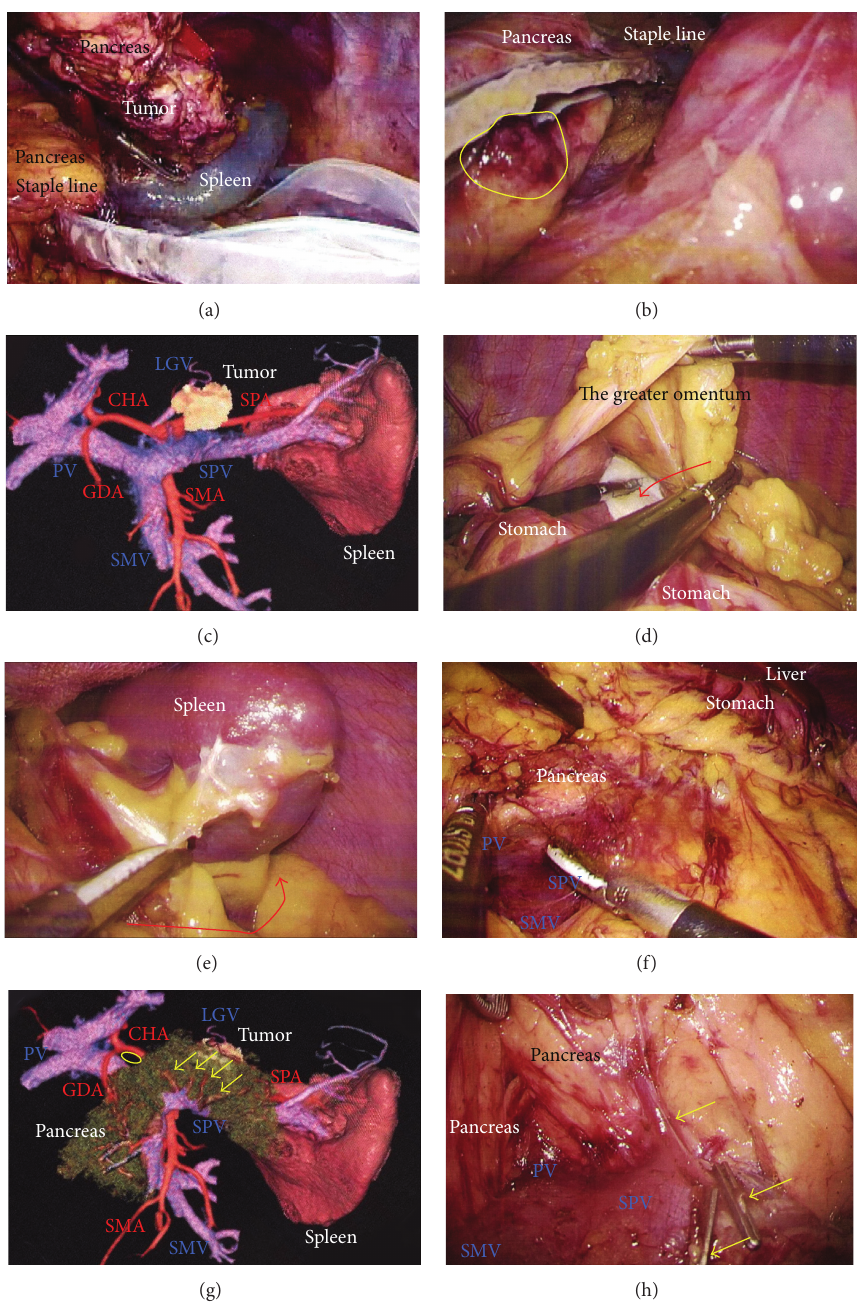
Figure 4: (a) The specimen was extracted through a 3 cm incision in an endobag to prevent dissemination by direct contact with the tumor. (b) The pancreatic stump and capsule were checked carefully. Subtle injury to the pancreatic membrane caused postoperative leakage of pancreatic fluid (yellow circle). (c) The tumor location and invasive signs were assessed carefully. (d) Gauze was placed on the splenic hilus as a landmark. The greater omentum was then cut (red arrow), and the omental bursa was opened. The left gastroepiploic vessels were cut. (e) The splenocolic ligament along the inferior spleen was then cut (red arrow). It was critical that the reverse side of the thin membrane of the transverse mesocolon was confirmed beforehand, via a bird’s-eye view. (f) The confluence of the SMV, SPV, and PV was confirmed. (g) Branches from the SPV were detected before proceeding further (yellow arrows). A suitable dissection point for CHA skeletonization was also determined preoperatively (yellow circle). (h) Venous branches from the SPV were then skeletonized (yellow arrows). These venous branches were singly clipped and then cut by LCS. CHA, common hepatic artery; LCS: laparoscopic coagulation sheers; PV, portal vein; SMV, superior mesenteric vein; SPV, splenic